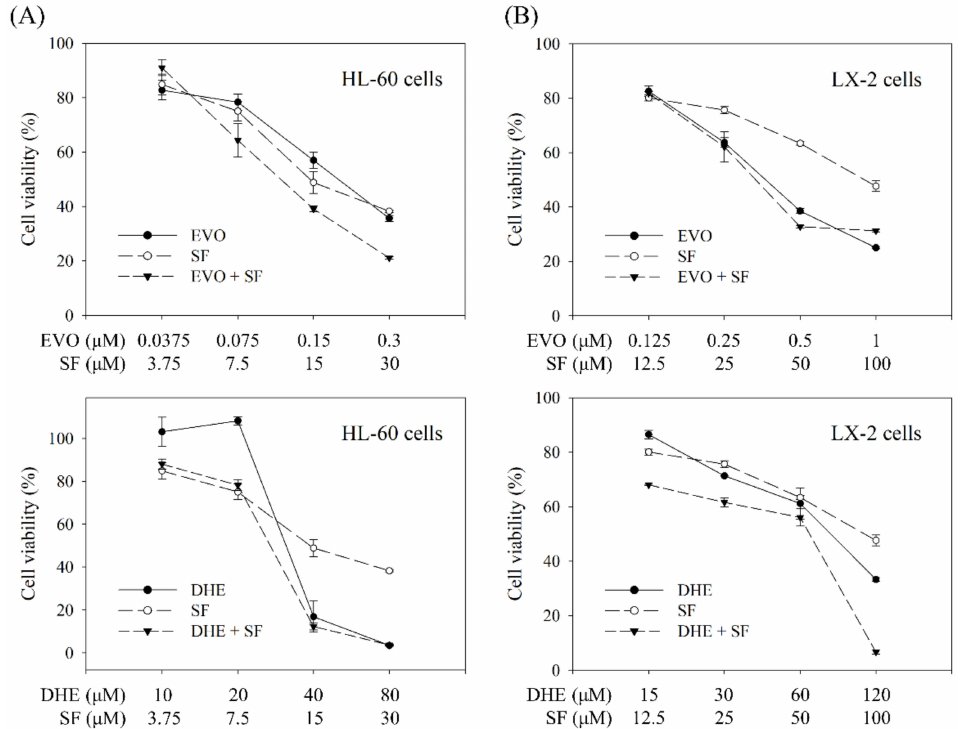
Figure 3. Individual and combined effects of evodiamine (EVO), dehydroevodiamine (DHE), and schinifoline (SF) on the cell viability: ( A ) Inhibitory effects on HL-60 cell growth. ( B ) Inhibitory effects on LX-2 cell growth. Cell viability was measured after 72 h treatment with single compound or the combination of two compounds. Data are presented as mean ± SD ( n =